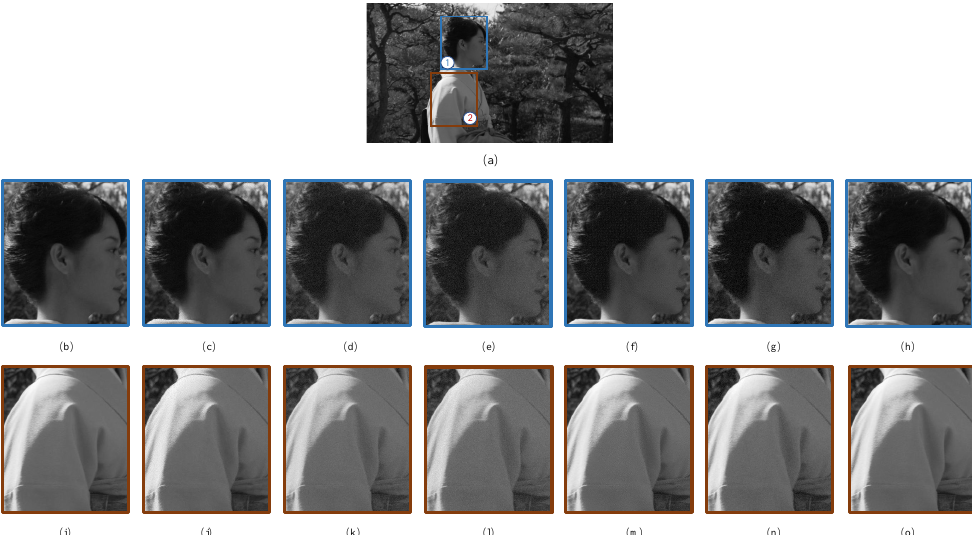
Figure 16. The 4th frame of the “Kimono1” sequence. ( a ) The original image; ( b – h ) are the enlarged images of the sub-region (cid:172) ; ( i – o ) are the enlarged images of the sub-region (cid:173) . In turn, they are the original patch and the distorted versions processed by Bae 2017, Zeng 2019, Wang 2020, Xing 2021, Li 2022 and the proposed JND model, respectively. The PSNR values of the distorted versions are 27.53 dB, 28.17 dB, 27.76 dB, 27.10 dB, 27.98 dB and 26.69 dB,